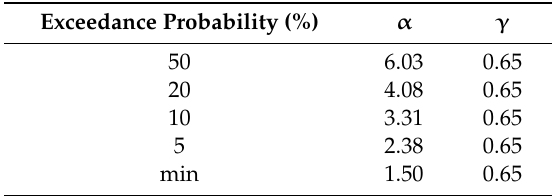
Table 3. Values of parameters α and γ at different exceedance probabilities.